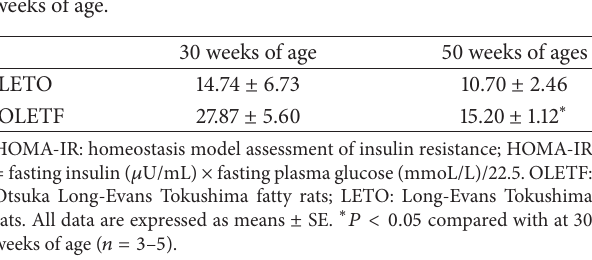
Table 3: HOMA-IR level of the LETO and OLETF rats at 30 and 50 weeks of